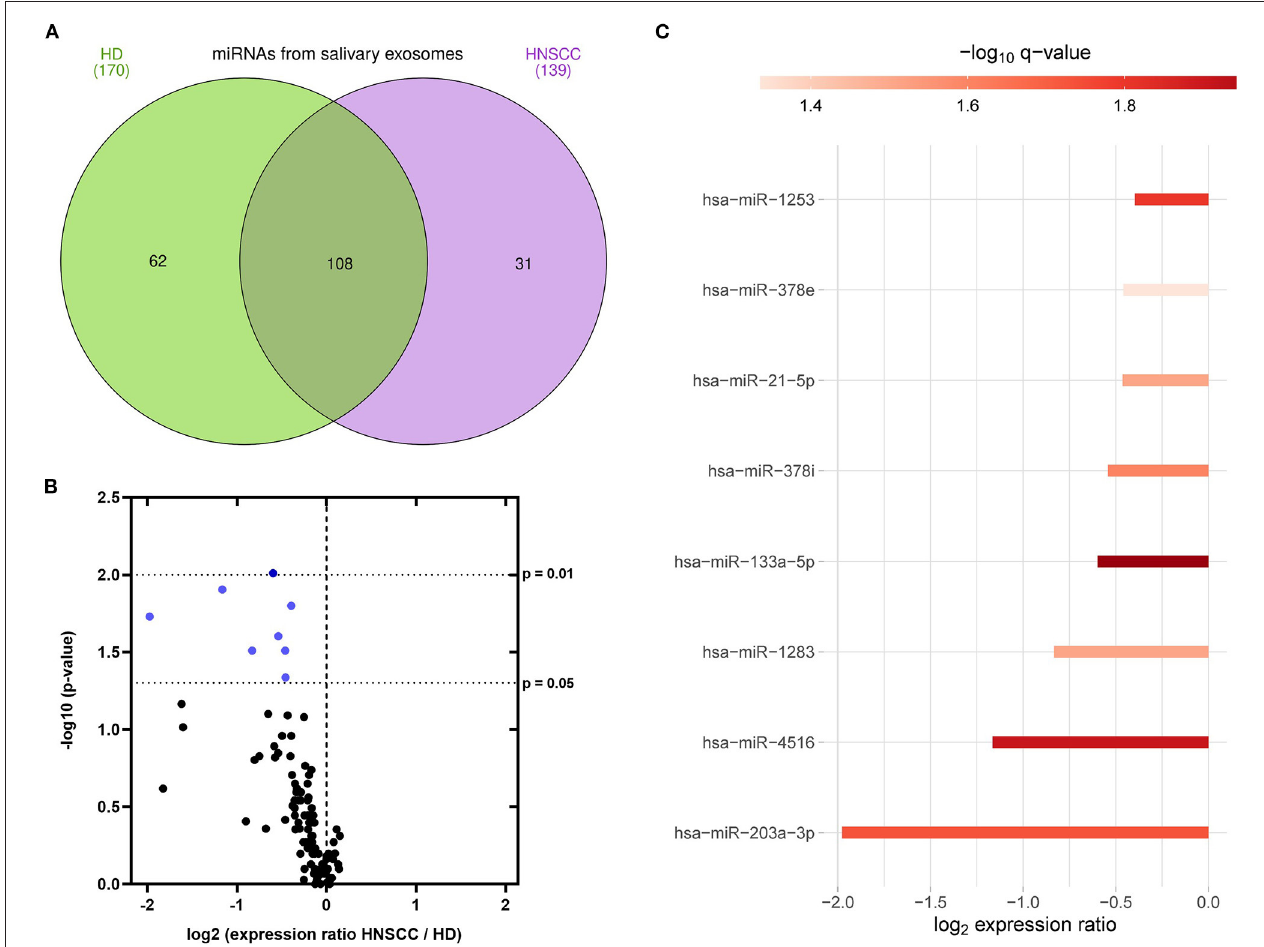
FIGURE 5 | miRNA profiling of saliva-derived exosomes. (A) Venn diagram of miRNAs detected in saliva-derived exosomes of HD (green, n = 7) and HNSCC patients (purple, n = 14), created with InteractiVenn ( 36). (B) Volcano plot showing the log2 expression ratio of 101 miRNAs overlapping between saliva-derived exosomes of HD and HNSCC patients. Each dot represents one miRNA. miRNAs at x > 0 are upregulated in HNSCC saliva-derived exosomes, while miRNAs at x < 0 are downregulated in HNSCC saliva-derived exosomes compared to HD. miRNAs in blue are significantly downregulated (p ≤ 0.05) in HNSCC saliva-derived exosomes compared to HD. (C) Waterfall plot of significant miRNAs from (B) showing the log2 fold change difference between HD and HNSCC saliva-derived exosomes. Red color indicates the negative logarithm of the p -value (the stronger the color, the more